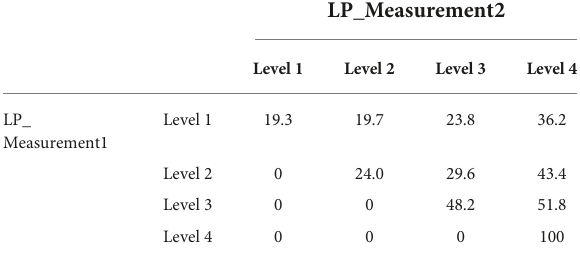
TABLE 5 Transition probability table (% Probability).